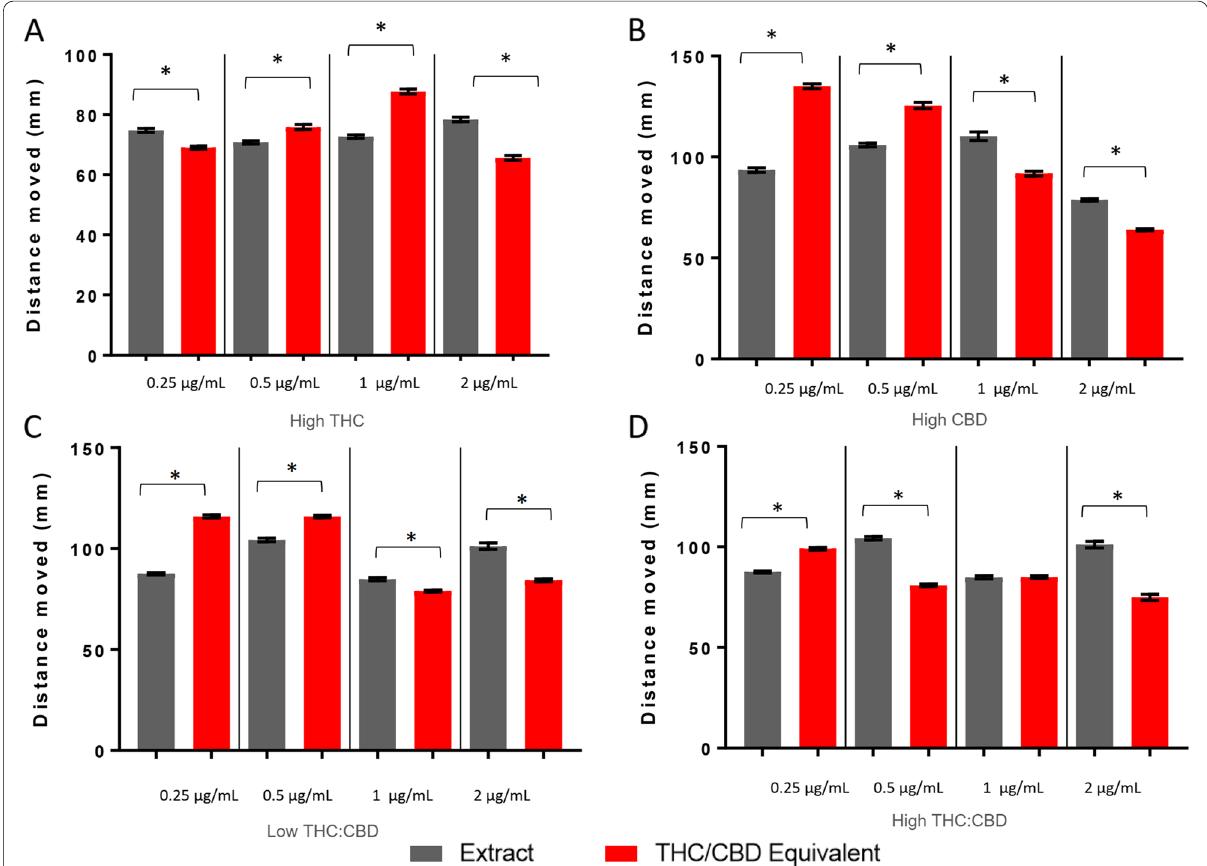
Fig. 4 Larval locomotion following exposure to high THC, high CBD, low‑temp THC:CBD, and high‑temp THC:CBD extracts. Larval behavioral profiles following exposure to the extract and molar equivalence of THC/CBD at varying concentrations. The average distance traveled presented over 30 min (60–89 min) of the light cycle. Each bar represents an n by ANOVA followed by a Bonferroni post hoc test ( p <